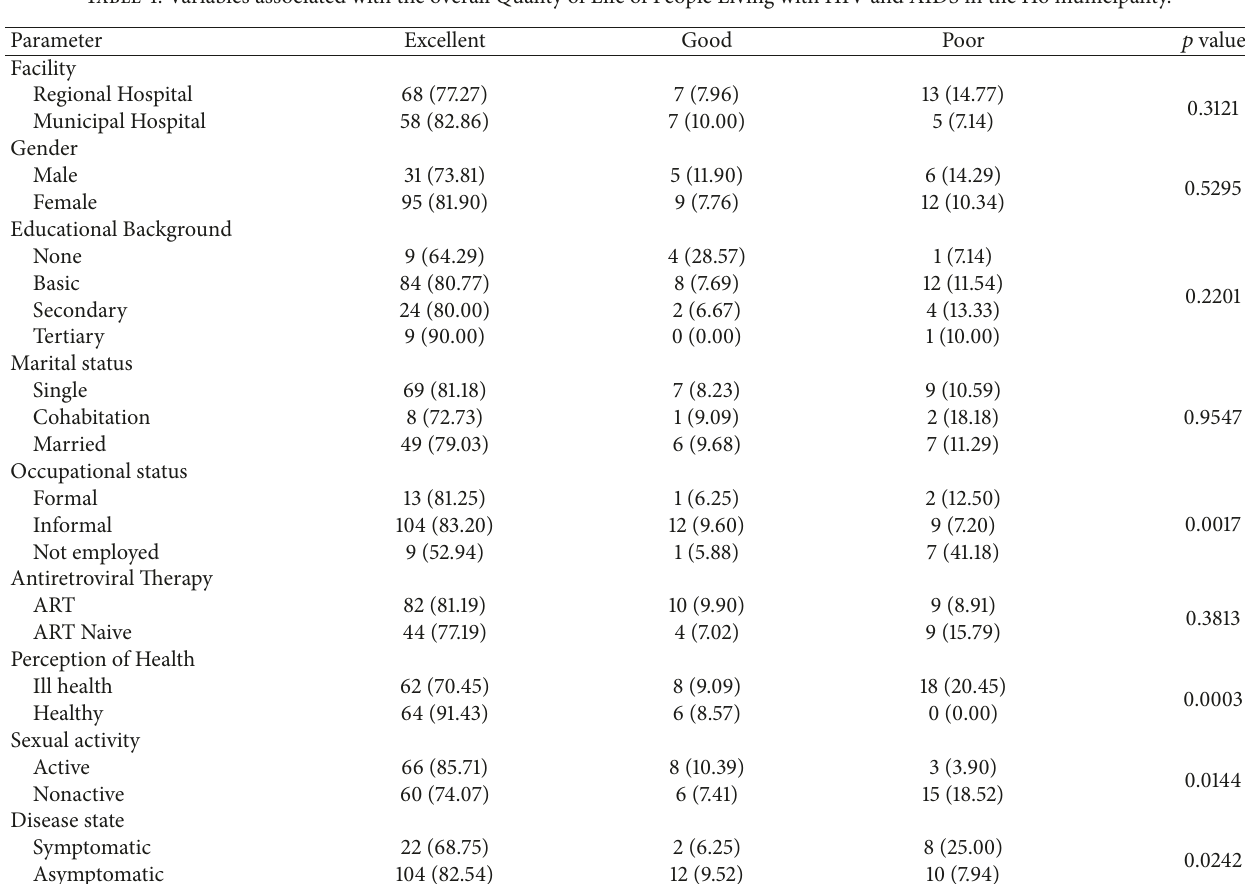
Table 4: Variables associated with the overall Quality of Life of People Living with HIV and AIDS in the Ho